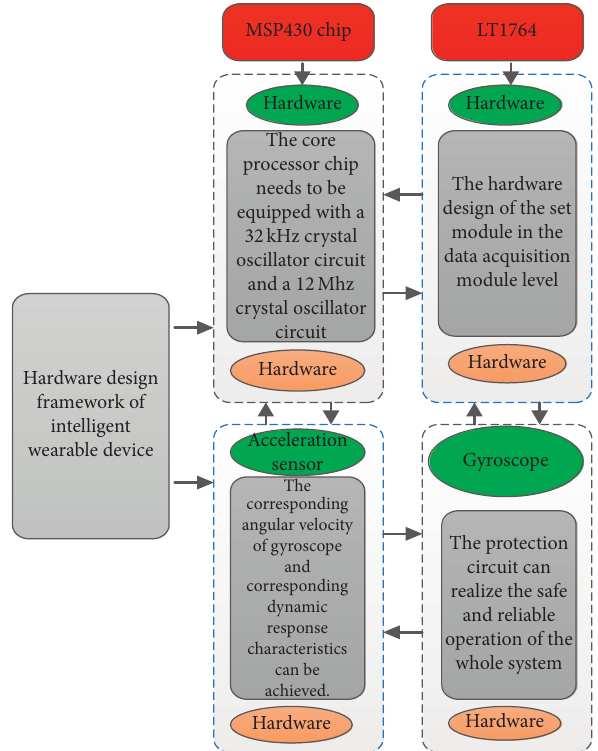
Figure 4: Schematic diagram of hardware configuration of wearable intelligent device.